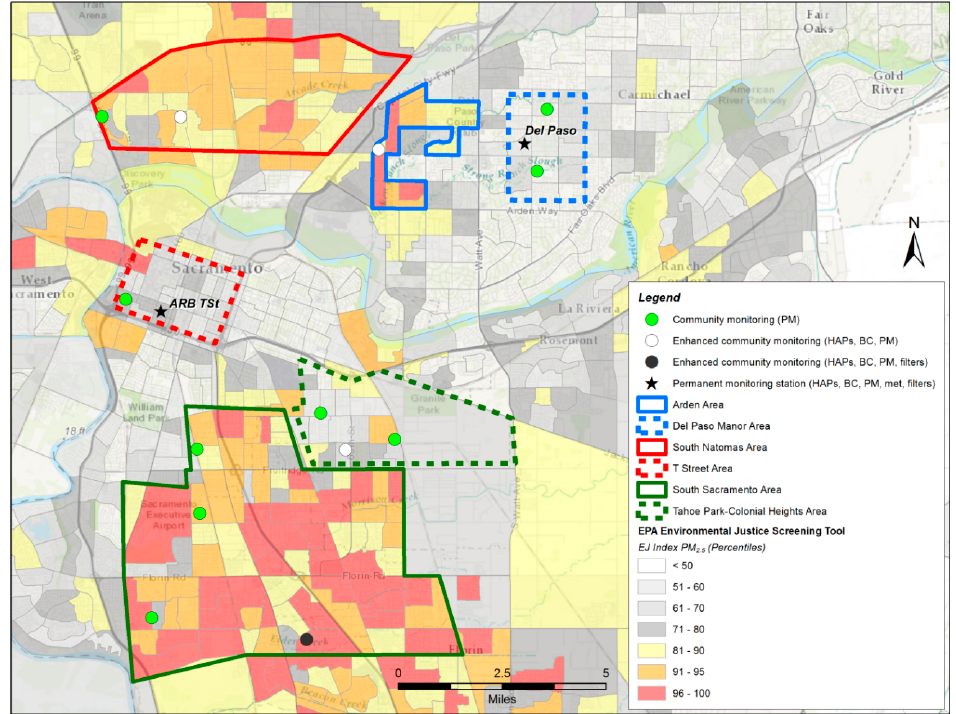
Figure 1. The Sacramento County communities where monitoring was conducted, the monitoring locations and pollutants monitored, and the Environmental Justice Index for PM 2.5 from EPA’s EJ Screen. HAPs: hazardous air pollutants. BC: black carbon. PM: particulate matter.